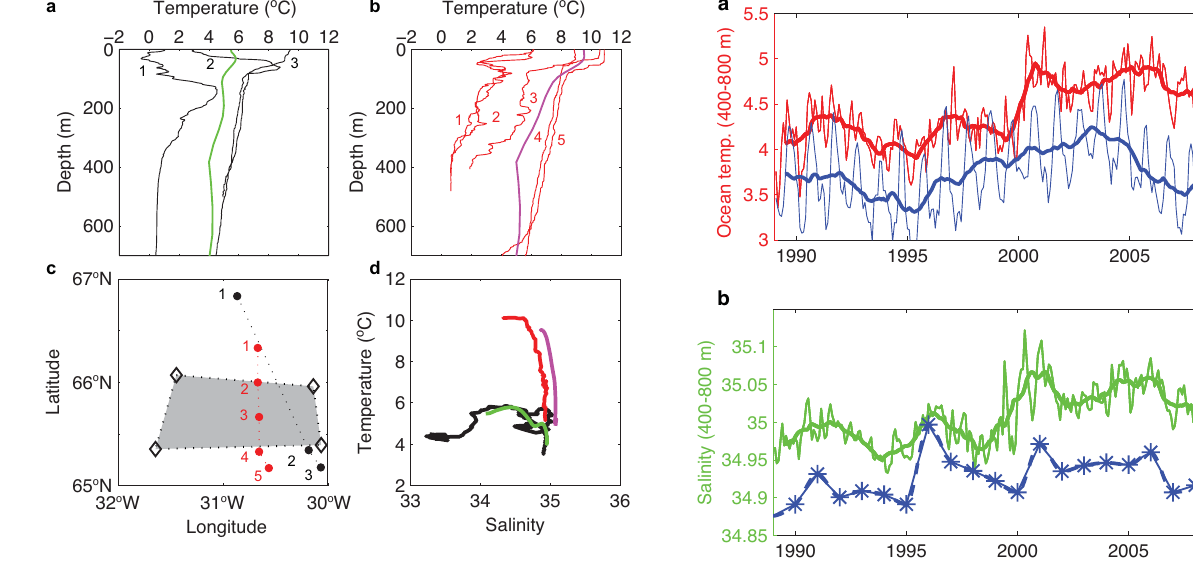
Fig. 6. (a) Temperature profile for September 1993 as seen in ocean reanalysis (green) and observations (black) at the outer continental shelf and slope. Numbers refer to stations whose location is shown in (c) . (b) Same as (a) but for September 2004. Ocean reanaly- sis data are shown by magenta line and red lines are observations. (c) Location diagram with black diamonds and grey shading illus- trating area used derive modelled temperature profiles as shown in (a) and (b) . The same area is used to derive the water mass proper- ties shown in Figs. 5 and 7. Black dots and dashed line show station transect and location of stations in 1993. Red dots and dashed line show station transect and location of stations in 2004. (d) Potential temperature and salinity for water masses as seen in ocean reanaly- sis for September 1993 (green) and September 2004 (magenta), and the mean of nearby observations from September 1993 (black) and September 2004 (red).